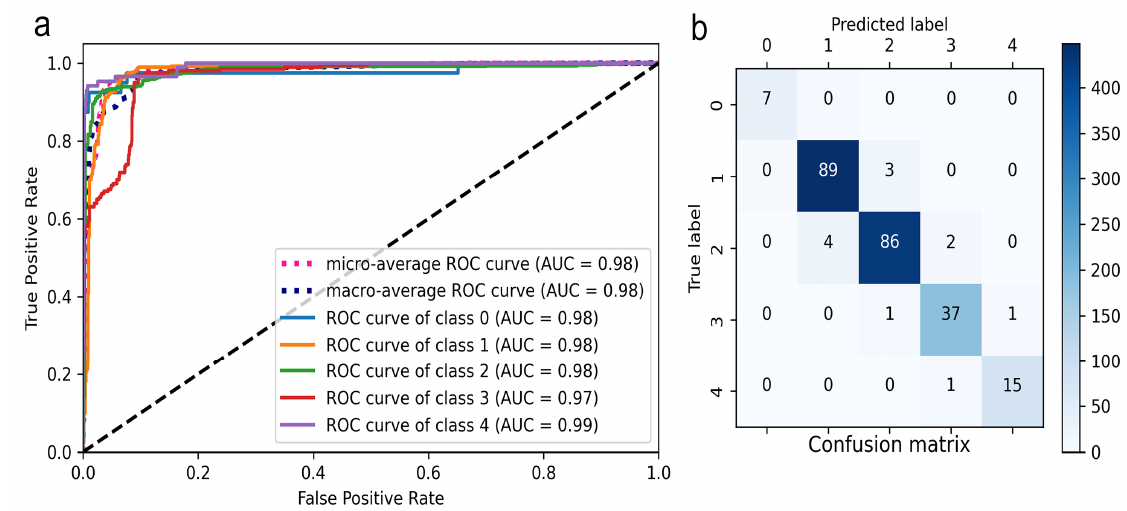
Figure 2. Performance of the deep learning model grading bulbar conjunctival injection. ( a ). Receiver operating characteristic curves for bulbar conjunctival injection grading (true positive rate- y axis; false positive rate- x axis); ( b ). Confusion matrix for the deep-learning model and manual labelling. The confusion matrices summarized the count of each grade in the bulbar conjunctival injection identified by the model or ophthalmologists. The agreement between the predicted label and ground truth was high among all grades in conjunctival injection judgment. Table 1. Performance of the deep learning model grading bulbar conjunctival injection. Accuracy Precision Recall F1-Score Cohen’s Kappa